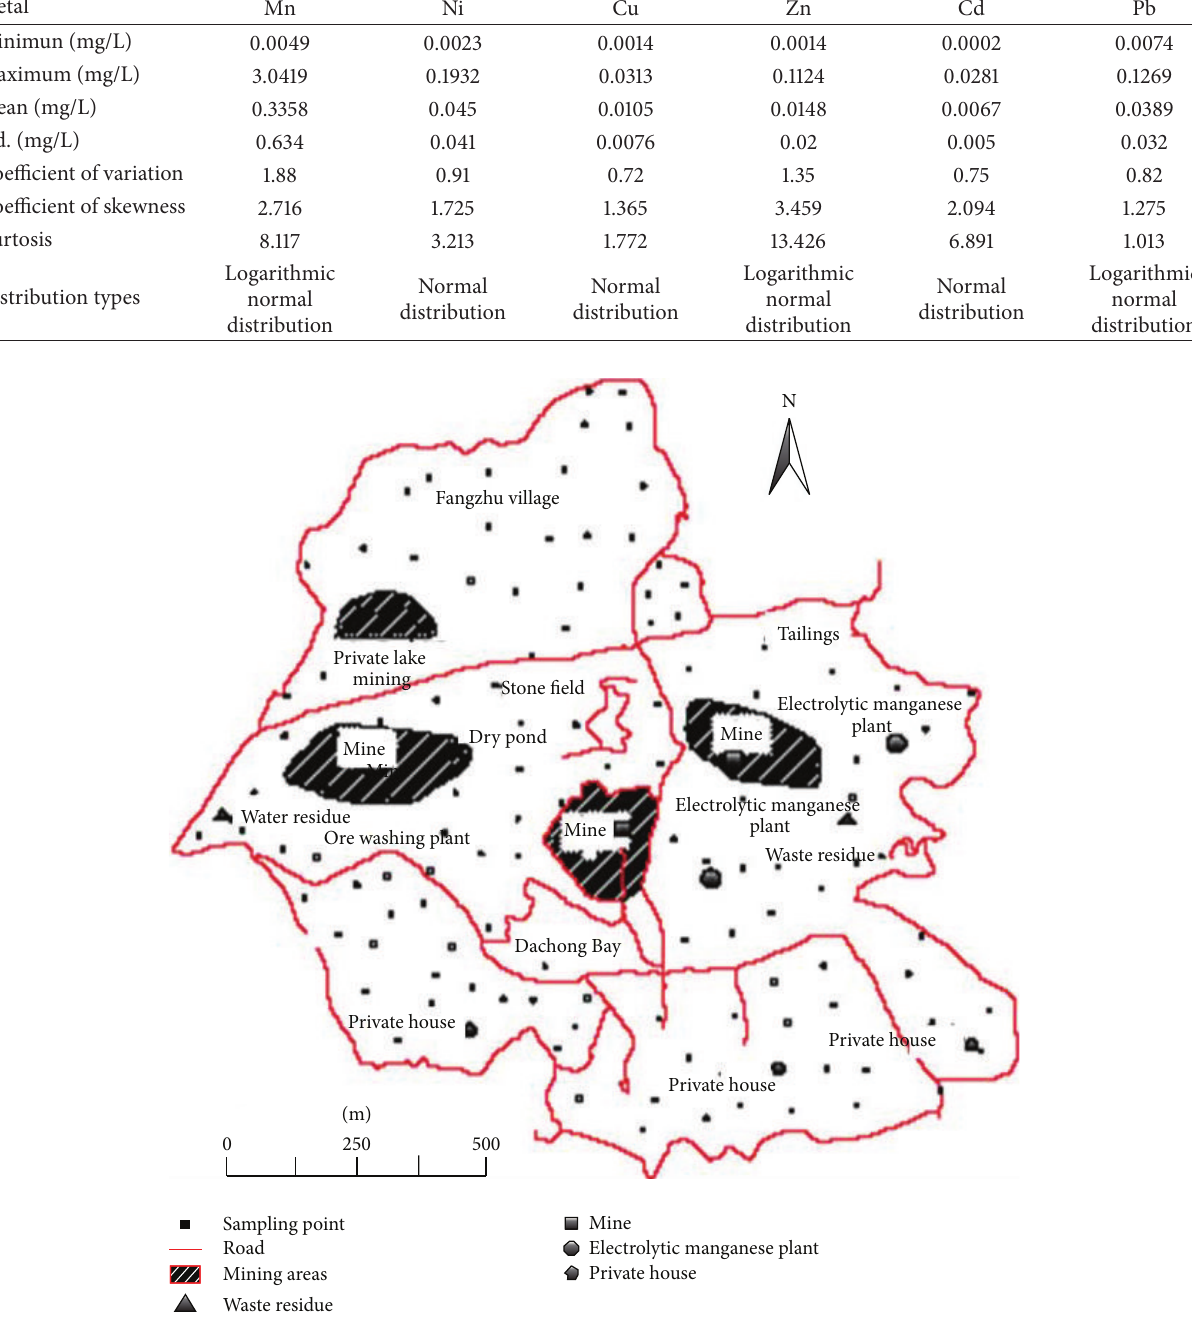
Figure 1: Map of monitoring